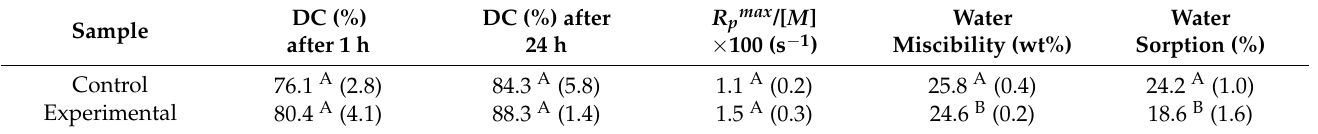
The values in parentheses indicate the standard deviation. The same letter after the mean values indicates no statistically significant difference ( p <